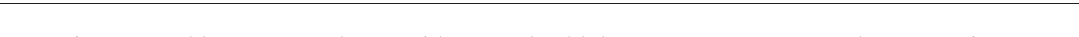
Fig. 7 OXT increases activity of CA3 pyramidal neurons. a A schematic of the approach to label PVN-projecting OXT neurons by injection of CTB-555 into the hippocampal CA3 region and intraperitoneal injection of fl uoro-gold (4% w/v in 100 μ l saline). b Left panel , CA3 pyramidal neurons labeled by CTB-555 ( red ). Section was counterstained with DAPI ( blue ). Right panel , PVN neurons back-labeled from the hippocampal CA3 region. The CTB + cell bodies ( red ) were found in the caudal portion of the PVN and colocalized OXT ( green ) and fl uoro-gold ( pink ). The arrow indicates the site of injection. Data were replicated in four mice. Scale bars : left , 250 μ m; right , 100 μ m. c OXTR-containing CA3 pyramidal neuron was targeted for recording, fi lled with biocytin, and reacted with avidin-rhodamine. Scale bar : 20 μ m. d , e Representative traces and summary data comparing OXT (1 μ M)-induced membrane depolarization in hippocampal CA3 pyramidal neurons from WT and Oxtr − / − mice (WT, n = 8 neurons from 6 mice; Oxtr − / − , n = 10 neurons from 6 mice; * P < 0.05, unpaired two-tailed Student ’ s t test). f , g Representative traces and summary data comparing the effect of OXT (1 μ M) on action potential fi ring responses elicited by depolarizing current injection in hippocampal CA3 pyramidal neurons from WT and Oxtr − / − mice ( n = 10 neurons from 6 mice per genotype; ** P < 0.01, paired two-tailed Student ’ s t test). h Representative micrographs showing the expression of ChR2-EYFP in the subgranular zone of the DG